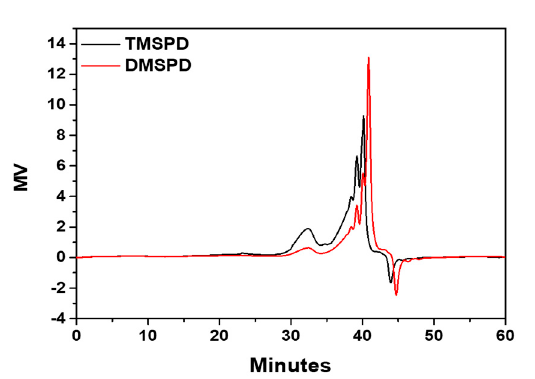
Figure 4. Gel permeation chromatography (GPC) data for methoxy-type SCAs after condensation side reactions.